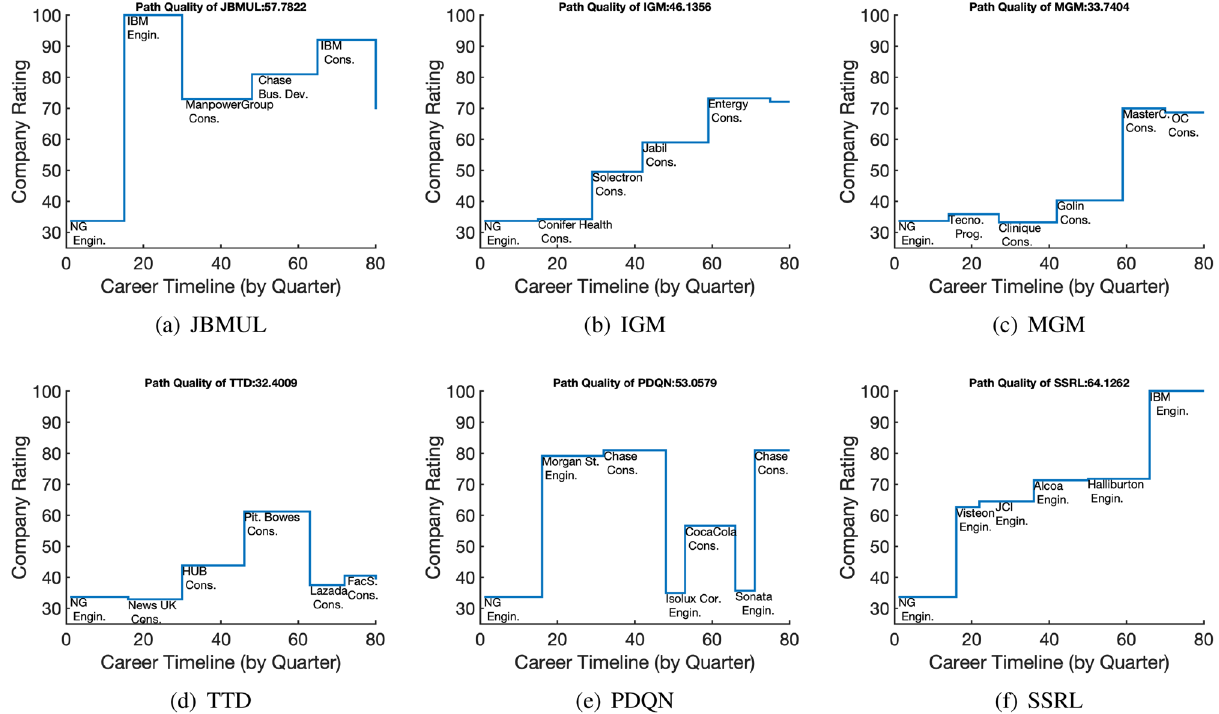
Figure 3. Career guidance. This figure illustrates career paths recommended by different methods, given the initial situation of an individual in the Navel Group as an engineer and with no specific user preference. We simulate 20-year career plans based on our method (SSRL) and five baseline methods. Compared to all baselines, SSRL shows a significant advantage in attaining the best-quality career path according to the pre- defined quality score. Also, SSRL recommended a gradually improved path, while all other baselines resulted in fluctuated quality of job mobility. If promotion and re-education information is not considered, SSRL tends to recommend the same-type of positions, while the companies may be from different